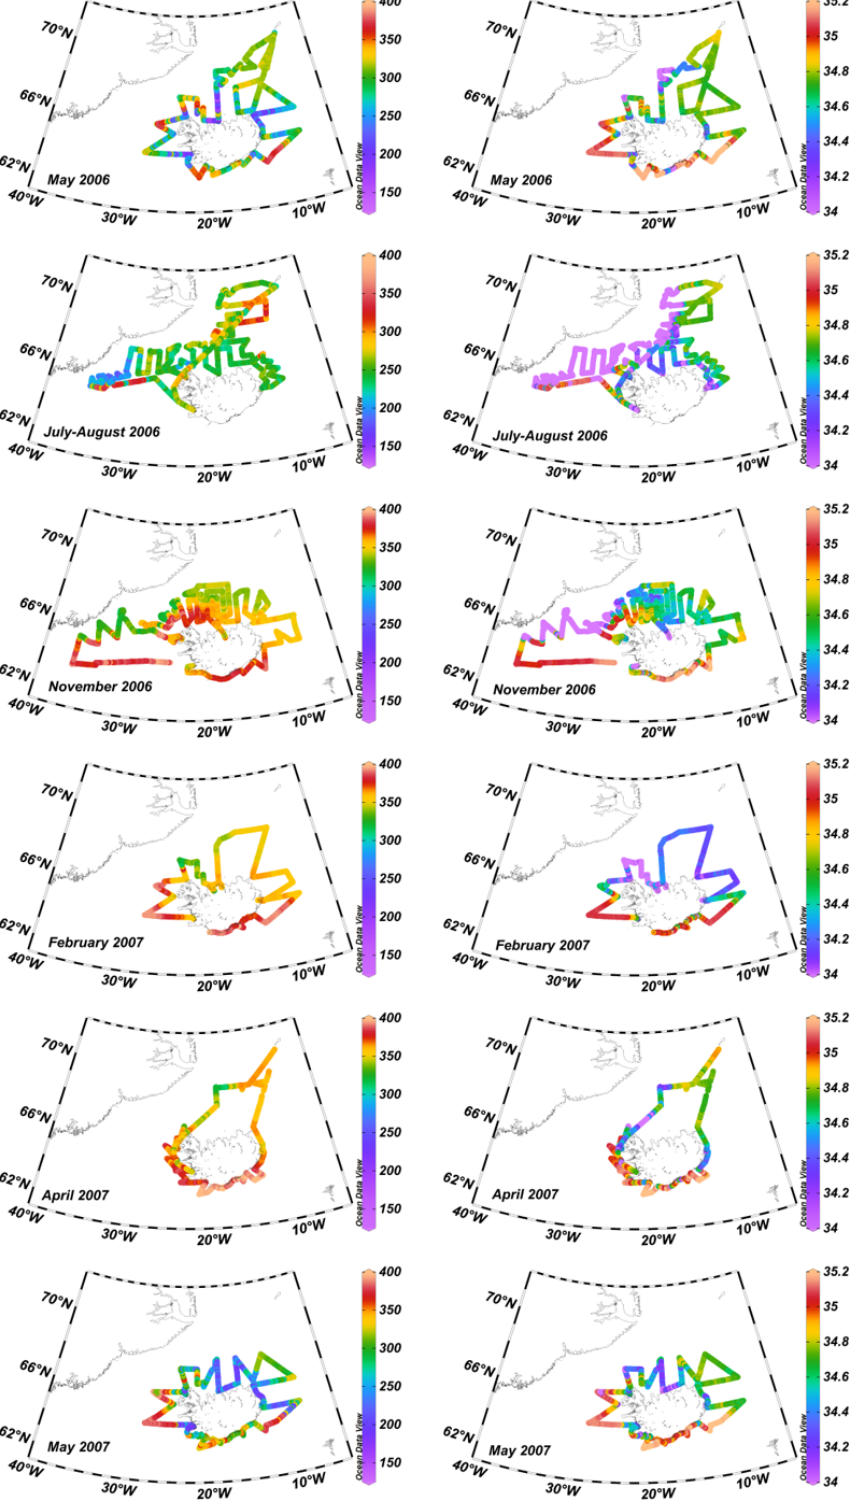
Figure 2. Cruise tracks where surface layer salinity and p CO 2 were recorded underway. The left column shows sea surface salinity, and the right column shows p CO 2sw (µatm) along the cruise tracks. Maps were drawn using the Ocean Data View programme (Schlitzer,